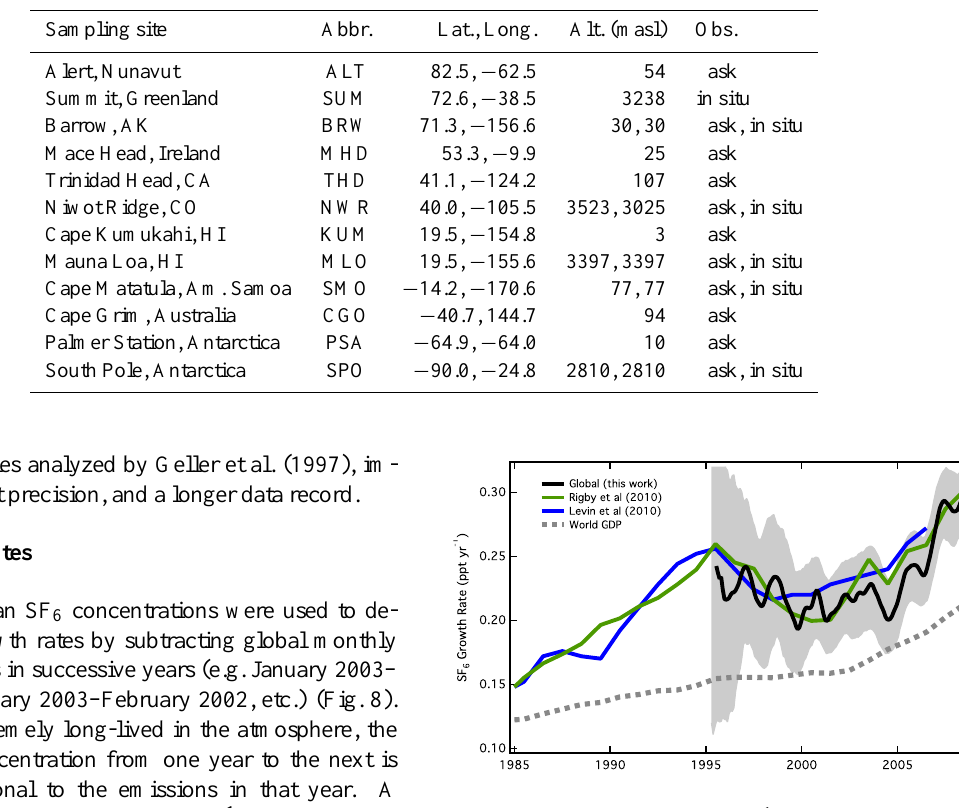
Fig. 8. Global growth rate (pptyr − 1 ) determined from flask and in Figure 8: Global growth rate (ppt yr -1 ) determined from flask and in situ combined SF 6 dataset. 559 situ combined SF 6 dataset. (shaded region is 2- σ ). Also shown are (shaded region is 2 σ ). Also shown are growth rates derived from emission estimated of Levin et 560 growth rates derived from emission estimated of Levin et al. 2010) al. (2010) and Rigby et al. (2010) along with World GDP (World Bank, 2011).561 and Rigby et al. (2010) along with World GDP (World Bank,